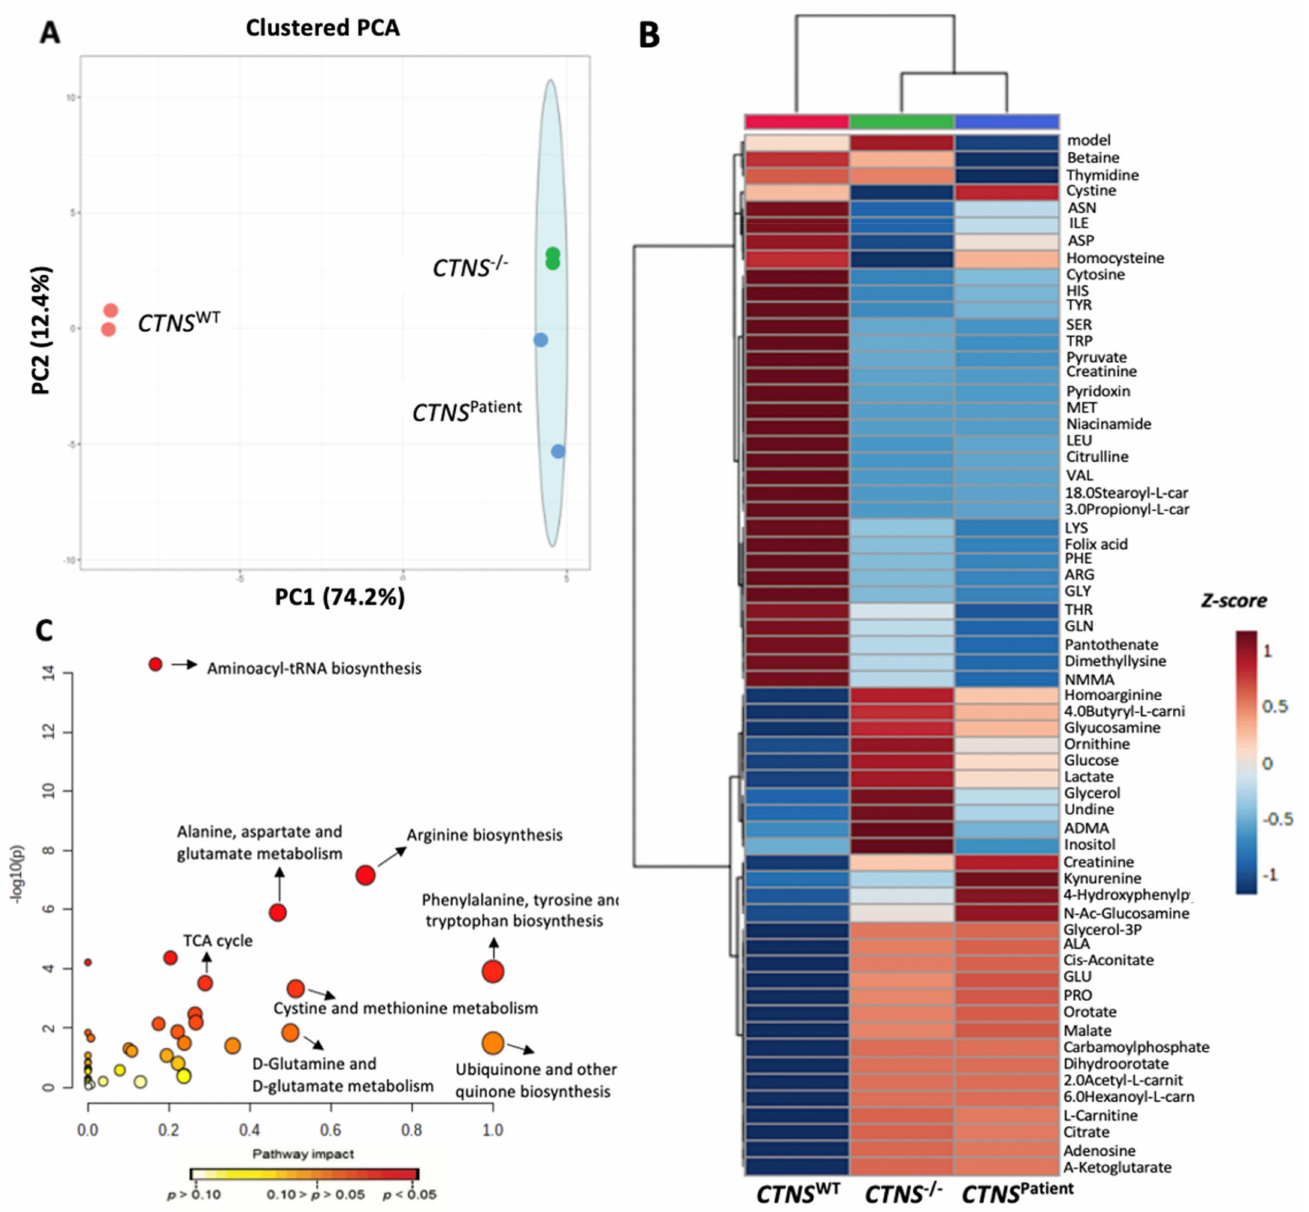
Figure 8. Metabolomic profiling of kidney tubules. Principal component analysis (PCA) of the ciPTEC CTNS WT , CTNS − / − , and CTNS Patient kidney tubule models based on the metabolites set measured. In the plot, the individual dots represent one biological repeat, and dots of the same color are the same experimental group (healthy ( CTNS WT , CTNS − / − and CTNS Patient kidney tubules) ( A ). Heatmap analysis of the top 60 metabolites differentially expressed in healthy and cystinotic kidney tubule models. Every row represents a different metabolite and its associated Z-score. Significantly increased metabolites ( p < 0.01) are displayed in red, and significantly decreased metabolites ( p < 0.01) are displayed in blue ( B ). Global pathway enrichment analysis of the metabolic pathways differentially expressed in the CTNS − / − compared to the healthy kidney tubules. The larger the circles and the further they appear from the y-axis, the higher the impact of that pathway in the CTNS − / − kidney tubules ( C ). Data was normalized to the median intensity. Data analysis was performed using univariate and multivariate analysis (N = 2; p -values < 0.05 were considered